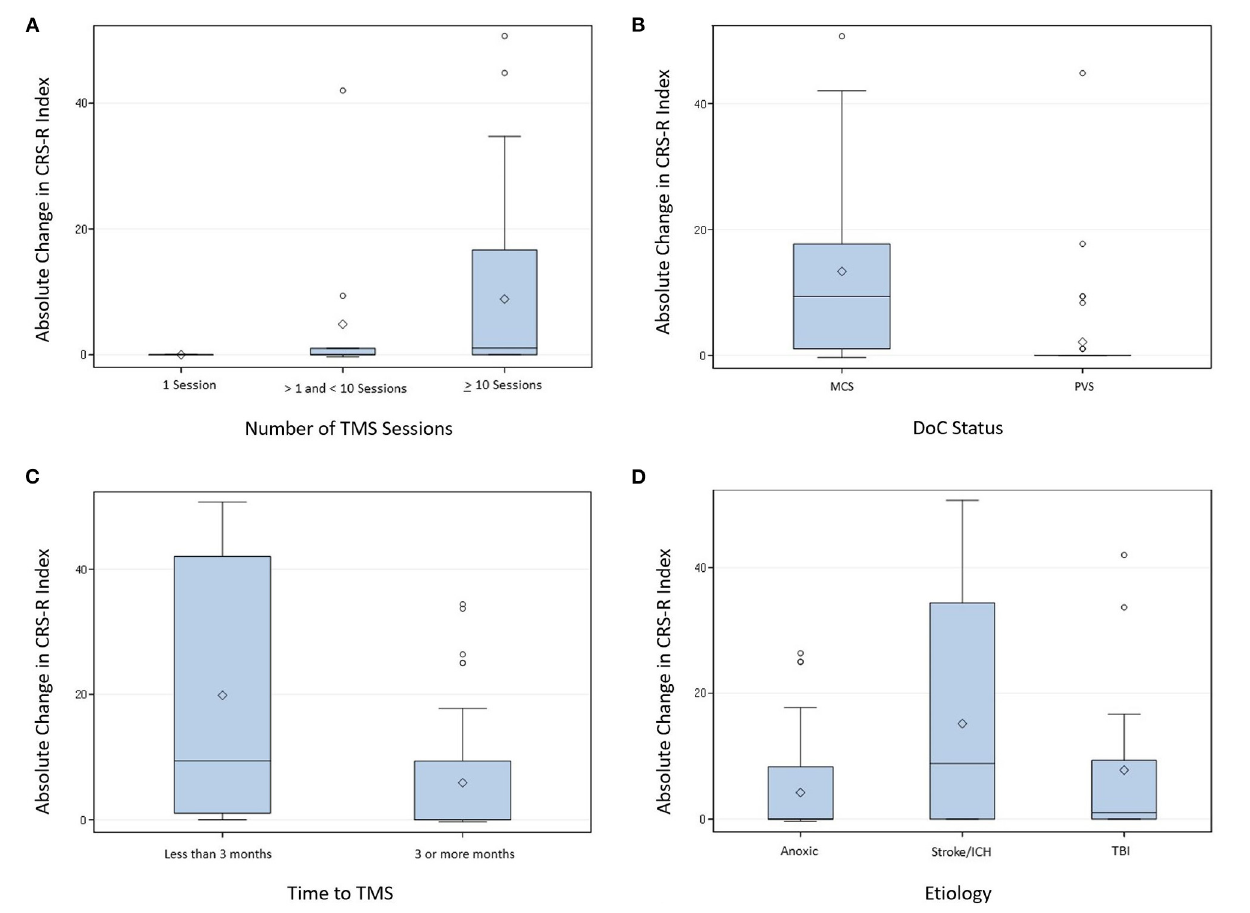
Frontiers in Neurology |